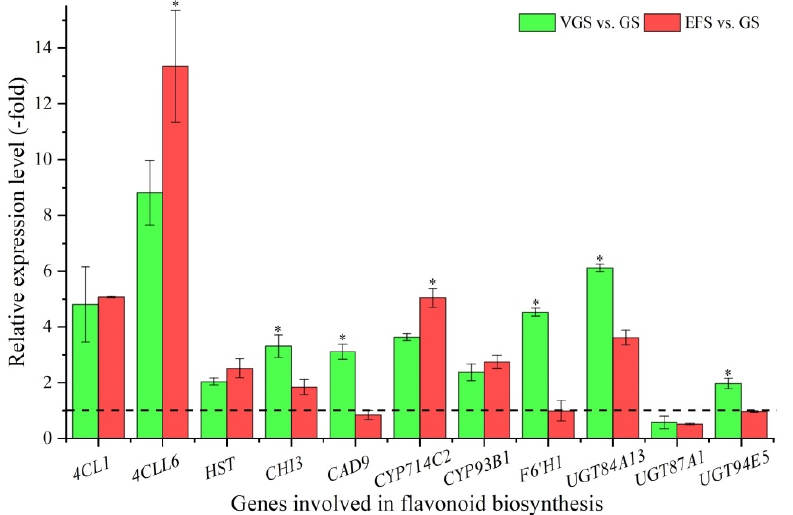
Figure 7. The relative expression level of genes involved in flavonoid biosynthesis at VGS and EFS vs. GS, as determined by qRT-PCR (mean ± SD, n = 3). The “*” represents a significant difference ( p < 0.05) at different growth stages for the same gene.